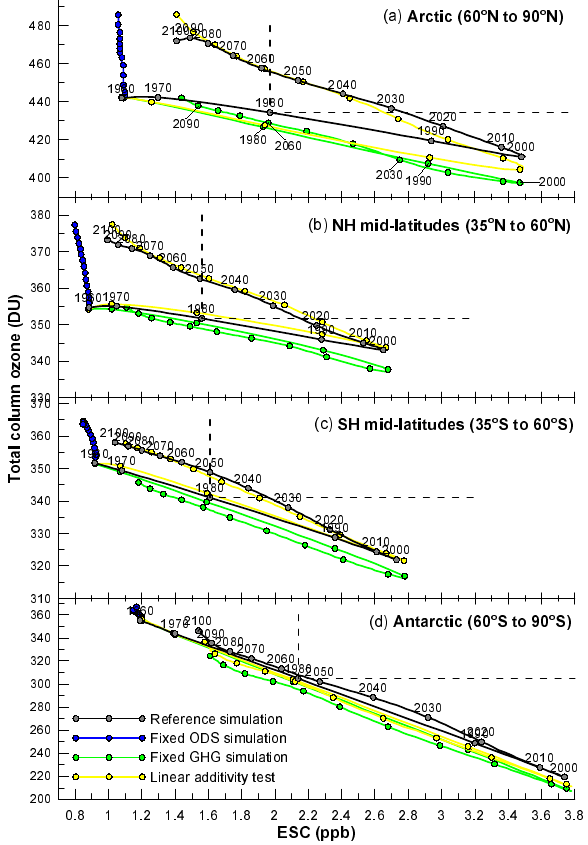
Fig. 7. As in Fig. 4, but for total column ozone in the midlati- tudes (annual average) and polar regions (March mean in Arctic and October mean in Antarctic). The multi-model mean is calcu- lated from all models that performed both fODS and fGHG simula- tions in addition to REF-B2 i.e. CCSRNIES, CMAM, MRI, ULAQ and WACCM. ESC is shown for 50hPa. Blue traces show results from simulations where prescribed ODSs are fixed at 1960 val- ues (fODSs). Green traces show results from simulations where prescribed GHGs are fixed at 1960 values (fGHG). Yellow traces show the additive effects of the fODS and fGHG simulations calculated from: Yellow ESC( t ) = fGHGESC( t ) + fODSESC( t ) – fODSESC(1960) and Yellow Ozone( t ) = fGHGozone( t ) + fODSozone( t ) − fODSozone (1960). Differences between the yel- low and REF-B2 traces indicate a lack of linear additivity in the